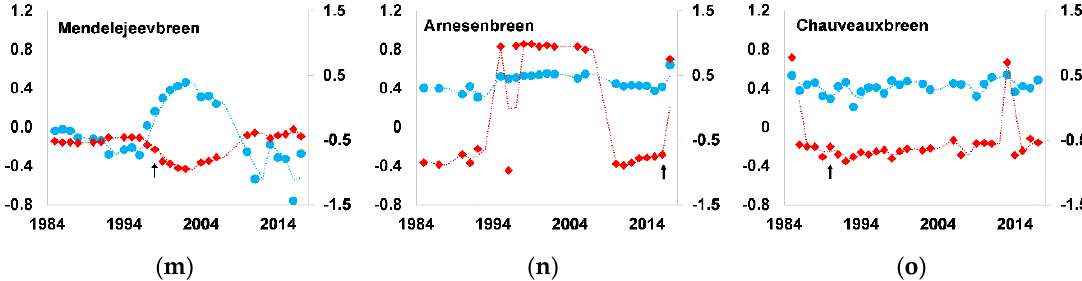
Figure 6. CfD (left Y axis; blue circles) and CfE (right Y axis; red rhombs) values for selected tidewater Spitsbergen glaciers, which experienced an episode of the active phase of the glacier surge in 1985–2017 (X axis–years): ( a ) the Nathorstbreen–Zawadzkibreen system; ( b ) Monacobreen; ( c ) the Strongbreen–Moršnevbreen system; ( d ) the Osbornebreen–Vintervegen system; ( e ) Tunabreen; ( f ) Wahlenbergbreen; ( g ) Paierlbreen; ( h ) Blomstrandbreen; ( i ) Richardsbreen; ( j ) the Persejbreen– Vindeggbreen system; ( k ) Esmarkbreen; ( l ) Fridtjovbreen; ( m ) Mendelejeevbreen; ( n ) Arnesenbreen; and ( o ) Chauveauxbreen. An arrow indicates the moment of the glacier movement forward. Table 2. The beginning and the end of the active phase of the glacier surge for selected Spitsbergen tidewater glaciers based on publications and morphometric indicators of the glacier frontal zone. According to the Ice-Cliff According to Published Data Morphometry Source of Data End (and Surging Glaciers Start of the (Published) Duration—in Active Brackets) of the Phase Active Phase